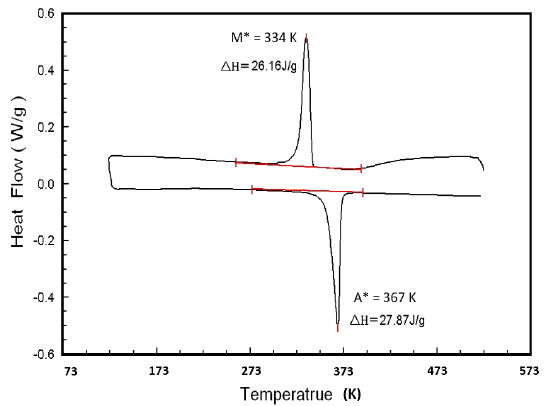
Figure 1. DSC curve of as-homogenized Ti 50 Ni 49 W 1 alloy. M *: The martensite peak temperature. A *: The austenite peak temperature.